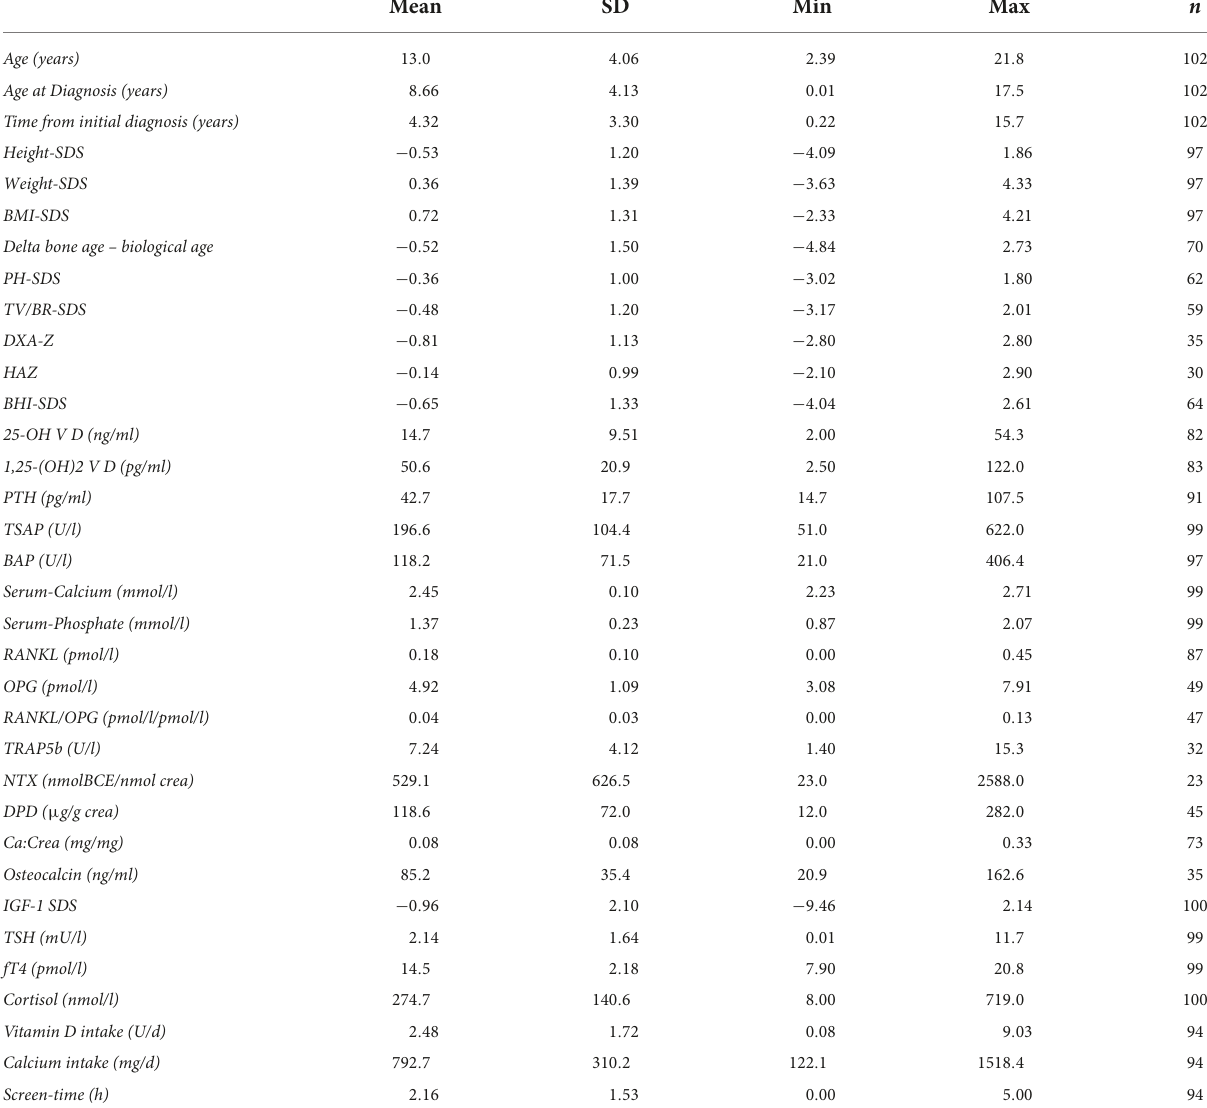
TABLE 2 Descriptive statistics of the cohort and parameters of bone